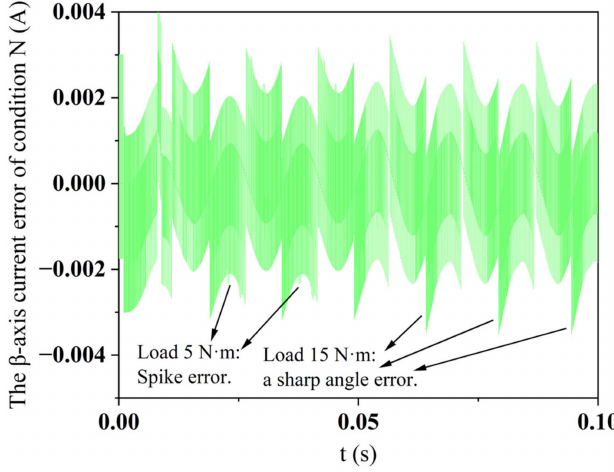
Figure 11. The β -axis current error of condition